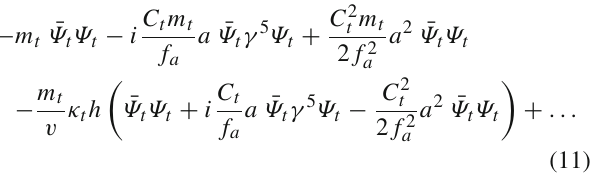
Fig. 6 Production cross section of a for LHC with for K g , eff / f a = 1 /